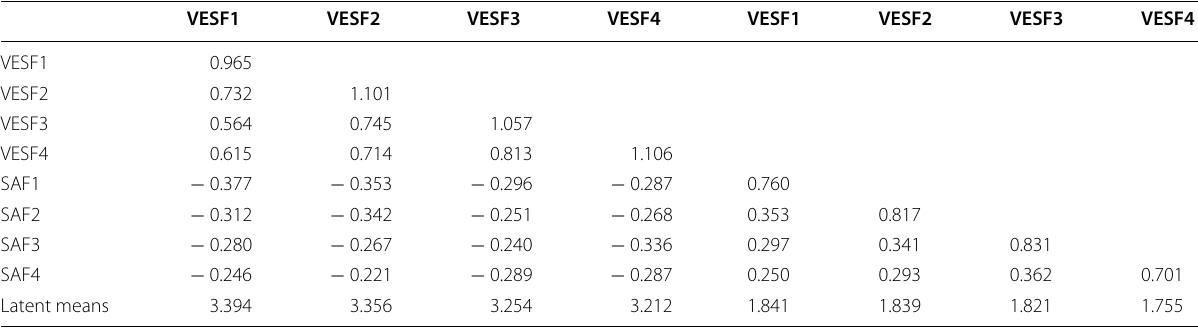
VESF refers to the value and enjoyment of science factor. SAF refers to the science anxiety factor. Numbers 1–4 appending VESF and SAF refer to the time